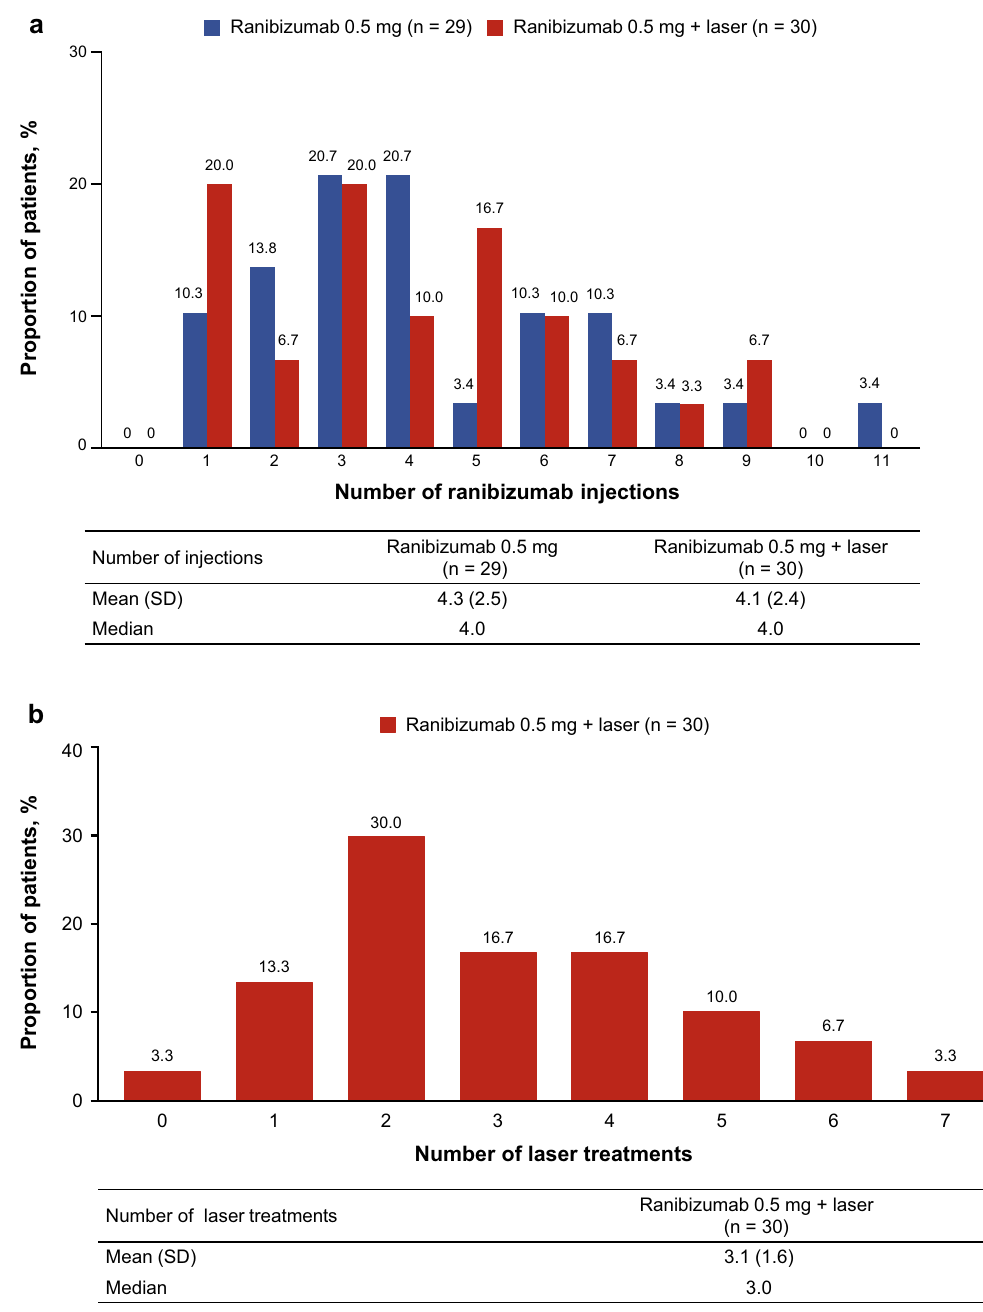
Figure 2. Treatments (full analysis set, observed). ( a ) Number of ranibizumab treatments from Day 1 to Month 11. ( b ) Number of laser treatments. SD standard